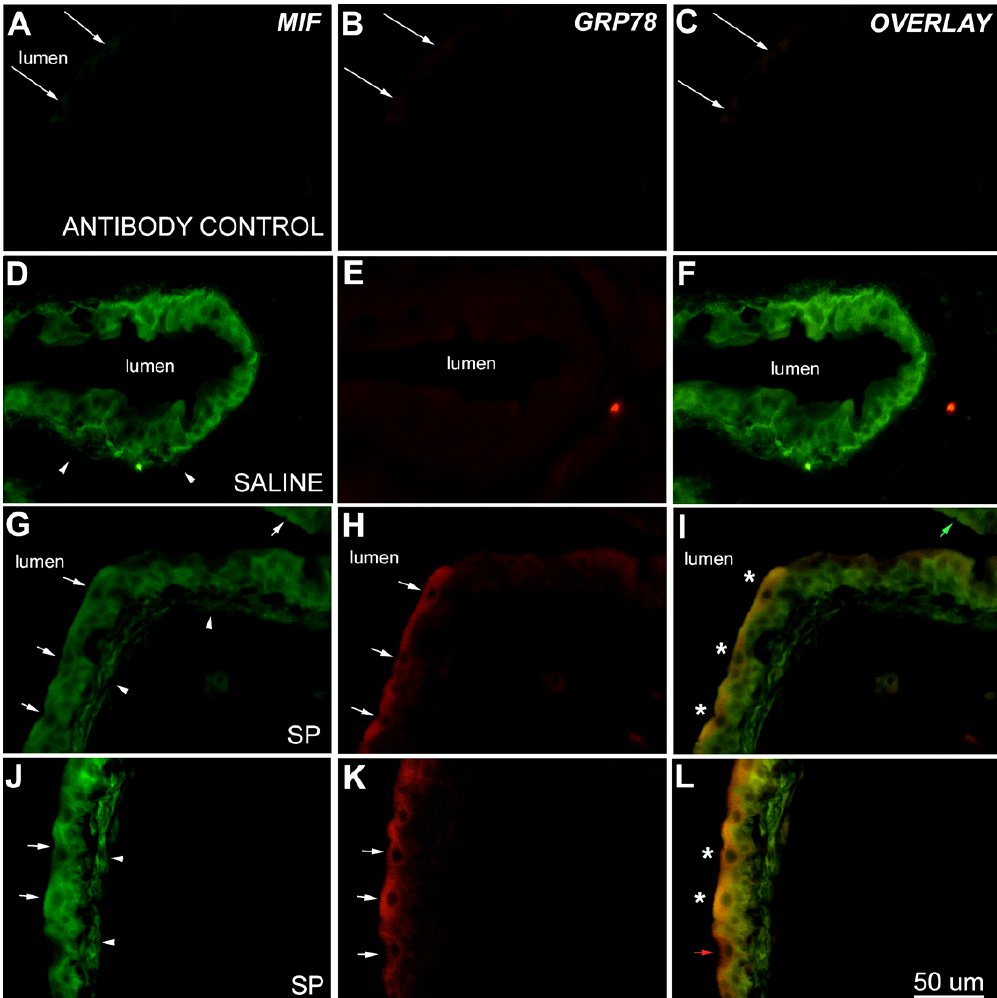
Figure 1. Substance P-induced MIF and GRP78 in umbrella cells. Single panels illustrating MIF (FITC labeling), GRP78 (TRITC labeling) and overlay of both (using Leica Imaging Software). Exposure times were constant for each particular fluorochrome and images were uniformly adjusted for brightness and contrast (Adobe Photoshop Elements v.2; Adobe Systems, San Jose, CA). Control sections where primary antibodies had been omitted showed no MIF (A) or GRP78 immunofluorescence (B). Consequently, overlay panel also shows no immunofluorescence (C). Arrows mark luminal edge of urothelium and slight autofluorescence can be seen. Representative sections showing urothelial immunostaining in saline-treated (D–F) and substance P-treated (G–L) bladders. Saline treated bladders showed MIF (D) immunostaining in the urothelium, whereas the urothelium appeared devoid of GRP78 immunostaining (E). Note MIF staining in basal and intermediate cells and light (or non-existent) immunostaining in umbrella cells (D). Overlay panel shows only MIF immunostaining (F). Arrowheads show location of the lamina propria, showing MIF immunostaining (D). In substance P-treated bladders, on the other hand, both MIF (G,J) and GRP78 (H,K) immunostaining was readily seen in the urothelium, particularly in umbrella cells (arrows). Overlay shows simultaneous MIF and GRP78 immunostaining as an orange color (indicated by asterisks; I,L). MIF only (panel I; green arrow) and GRP78 only (panel L; red arrow) umbrella cells can also be seen in the overlay panels. When compared to saline- treated bladders (D) MIF immunostaining in substance P-treated bladders is also increased in the fibroblast layer of the lamina propria (arrowheads, G,J). Calibration bar=50 m m.